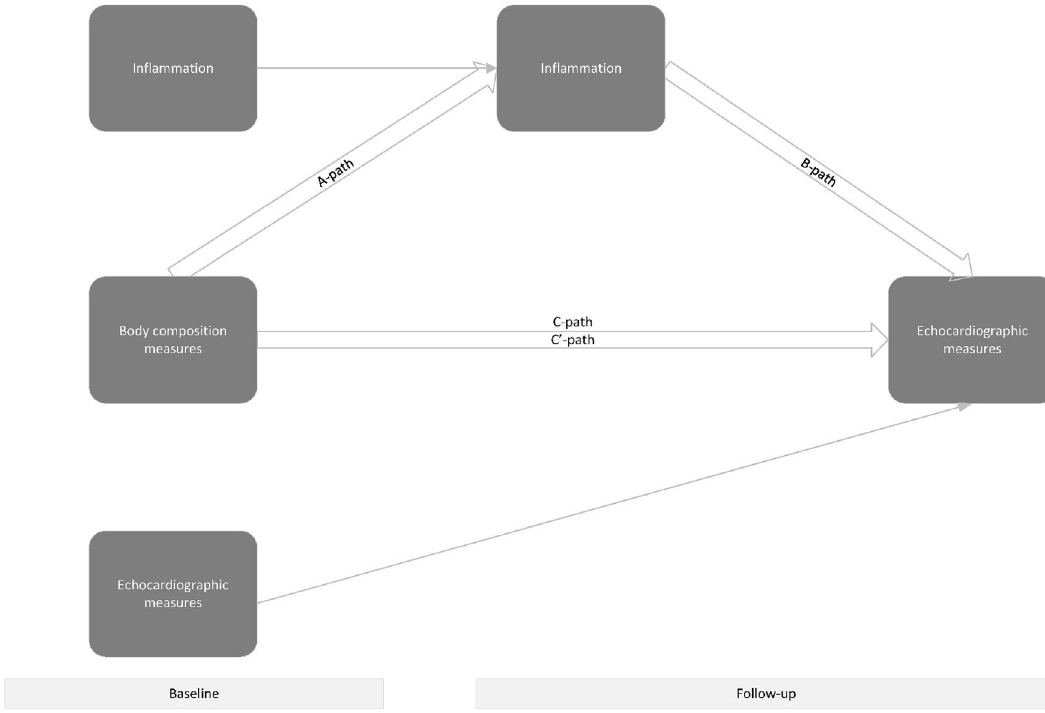
Figure 1. Directed Acyclic Graph of the relationship between trunk fat at baseline and echo parameters at follow-up, as mediated by inflammation at